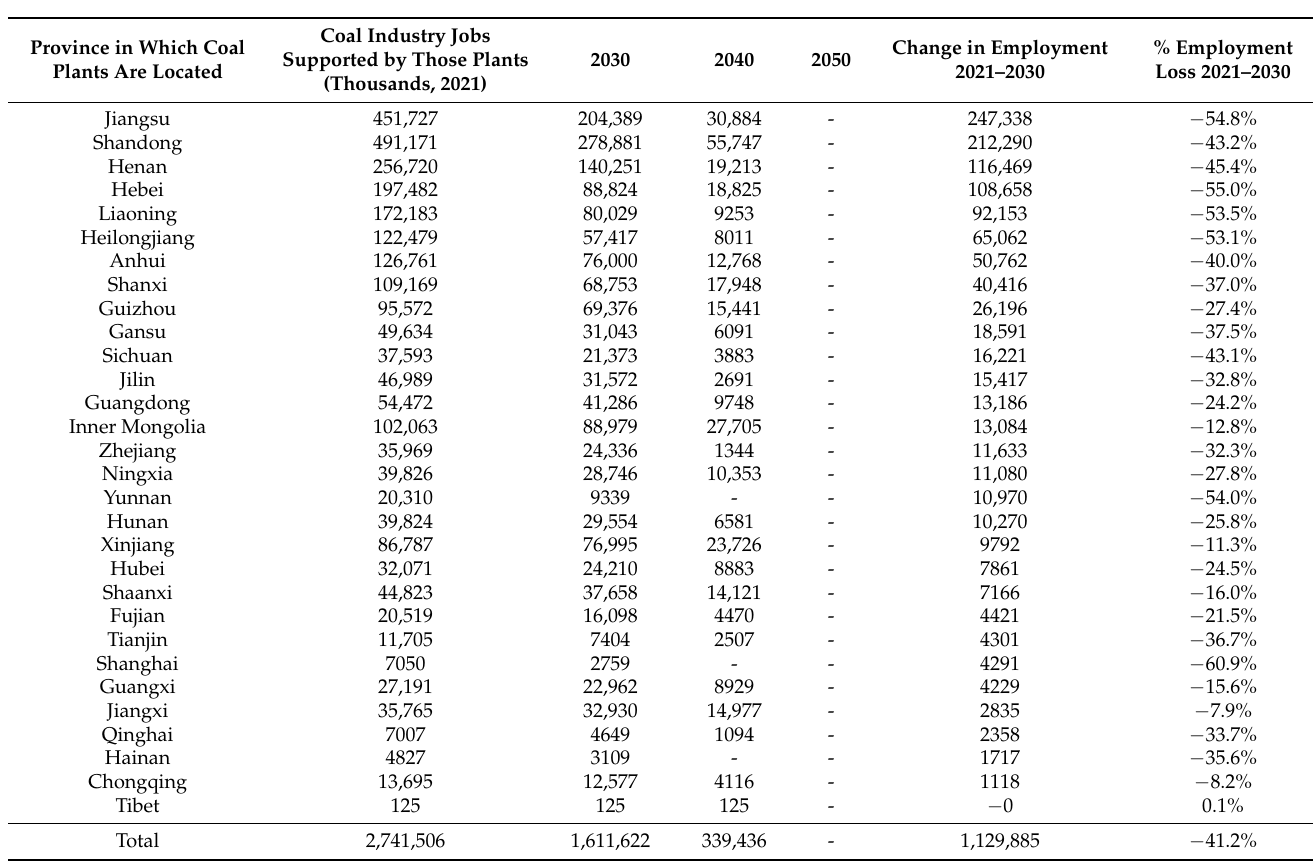
Table A4. Trends in coal industry employment supported by each province, 2021–2060 and change to 2030 (R scenario).